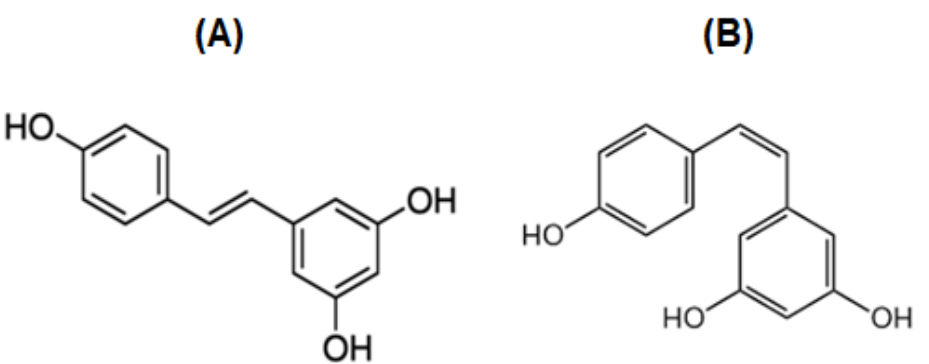
Figure 1. Chemical structure of trans ( A ) and cis ( B ) RSV.